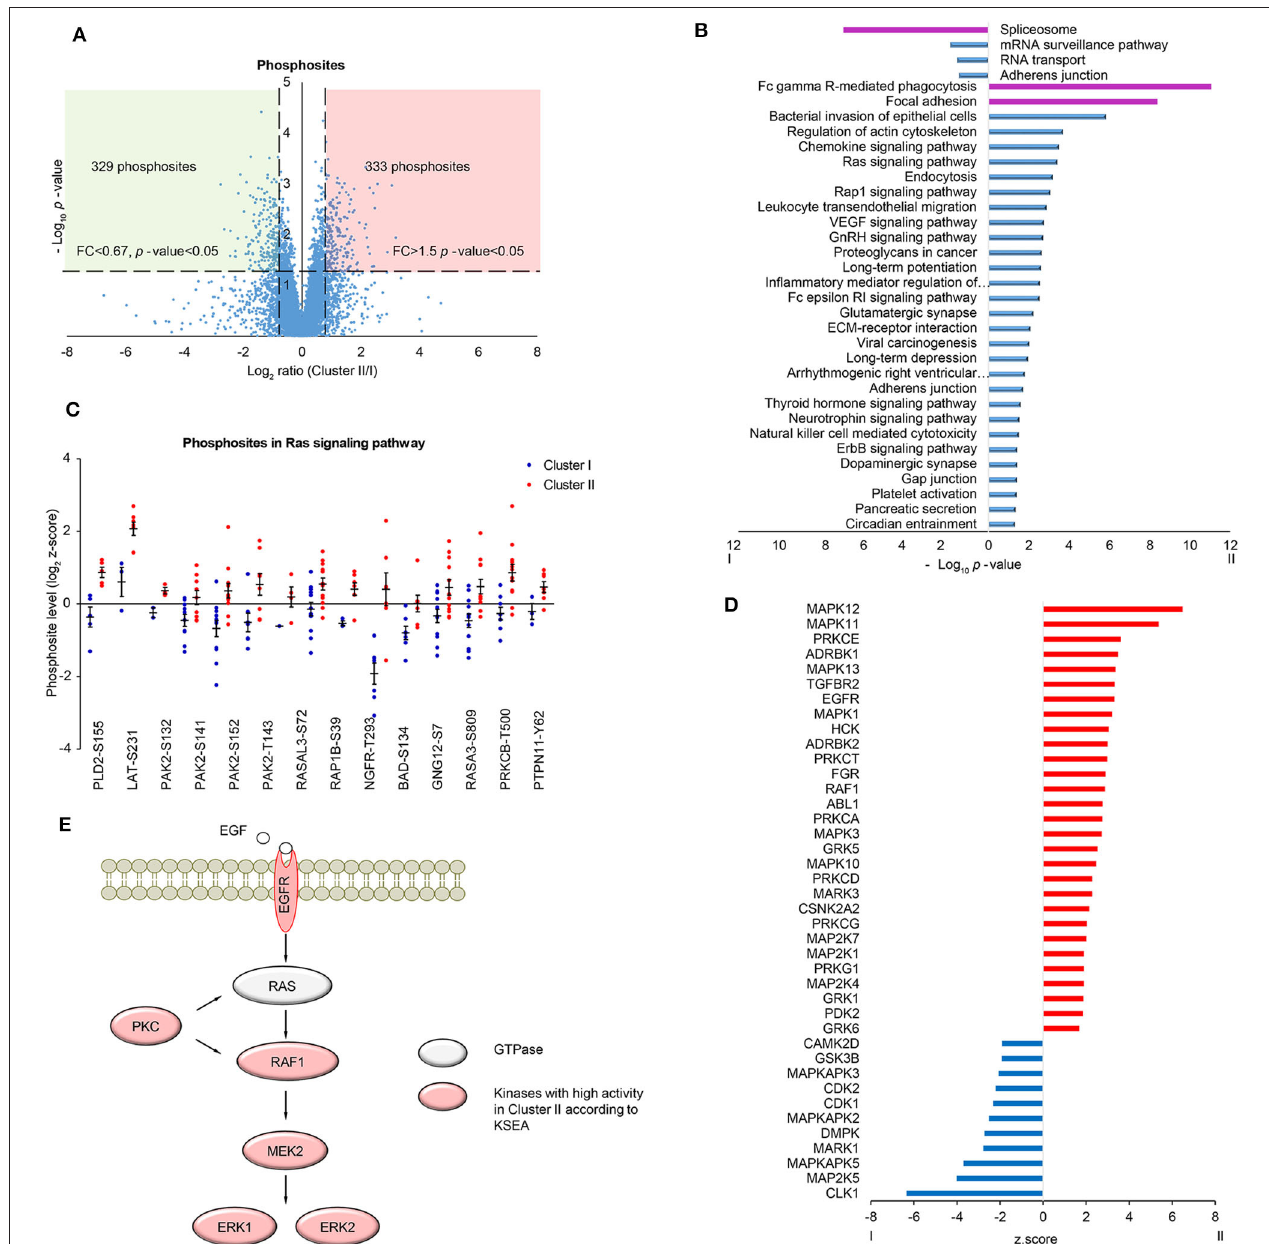
FIGURE 3 | Phosphoproteomic analysis of LUSC comparing cluster I with cluster II. (A) Scatter plot depicting the fold change in phosphosites comparing cluster II with cluster I. Log 2 fold changes were shown on the x-axis and -log 10 p -values are shown on the y-axis. The vertical dashed lines indicated fold change > 1.5 and the horizontal dashed line indicated p -value < 0.05 ( t -test). (B) DAVID analysis of phosphoproteomic data between cluster I and cluster II ( p -value < 0.05). The bar chart showed the enriched KEGG pathways of the differential phosphoproteins between cluster I and II (fold change > 1.5, p -value < 0.05). The highlighted pathways were consistent with those enriched in protein level (purple). (C) The quantification of phosphosites in Ras signaling pathway. Data were presented as dot plot with mean ± SEM. (D) Kinase-substrate enrichment analysis (KSEA) based on PhosphoSitePlus and NetworKIN database. Color blue/red for visual annotation of kinases that reached statistical significance ( p -value < 0.05). (E) A scheme showing the enriched kinases in the MAPK